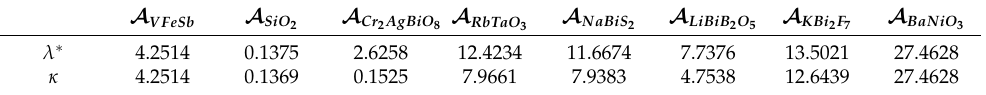
Table 2. Lower bound estimations of the largest C -eigenvalue in Theorem